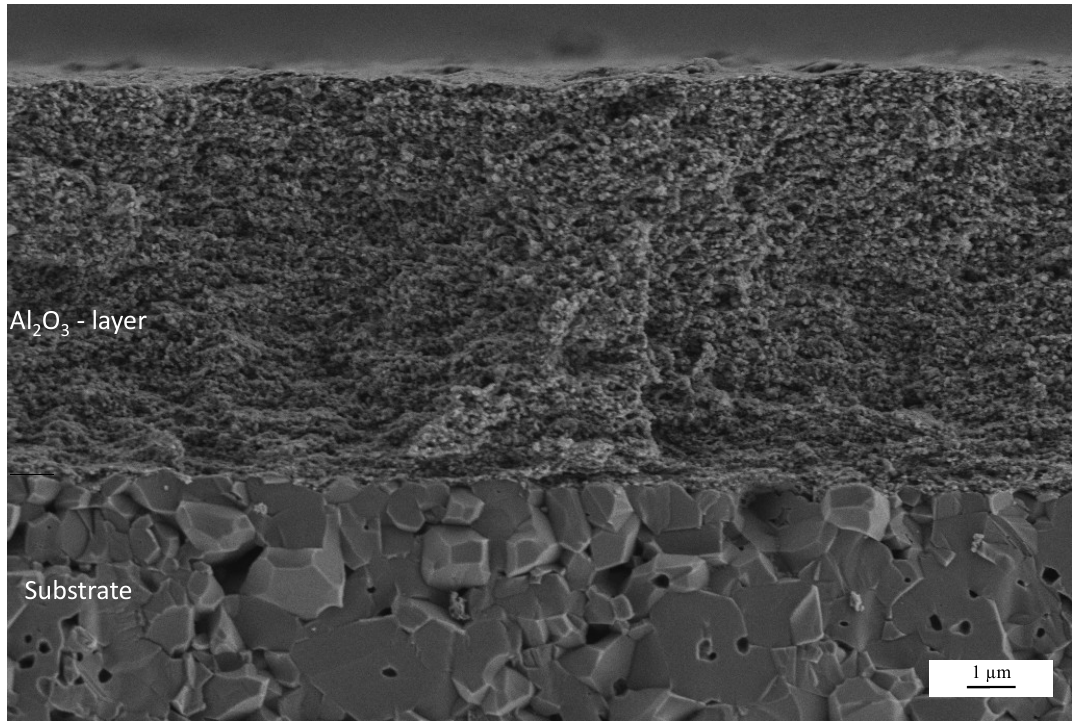
O AD layer sprayed on an 2 3 , film thickness t ≈ 8 2